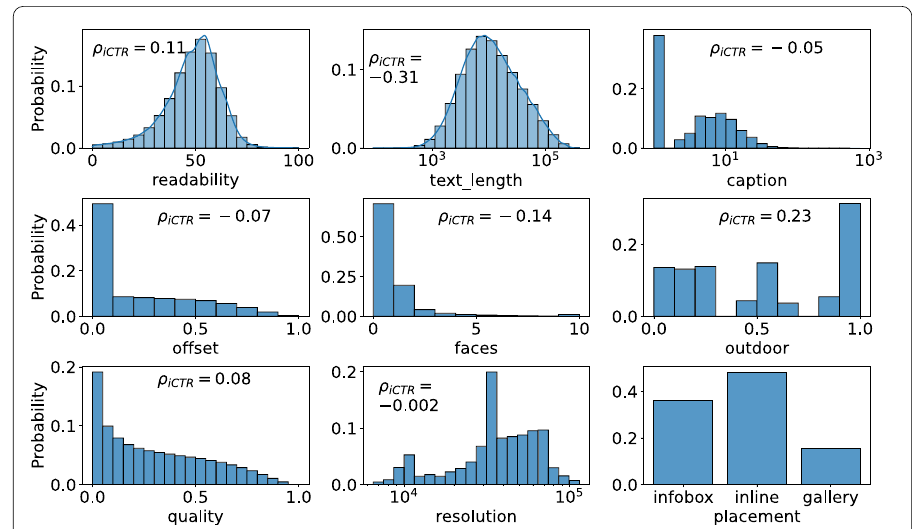
Figure 6 Feature distributions. Spearman’s rank correlation coefficient ρ between the numerical features and the iCTR at the top of each panel ( p < 0.001 for each